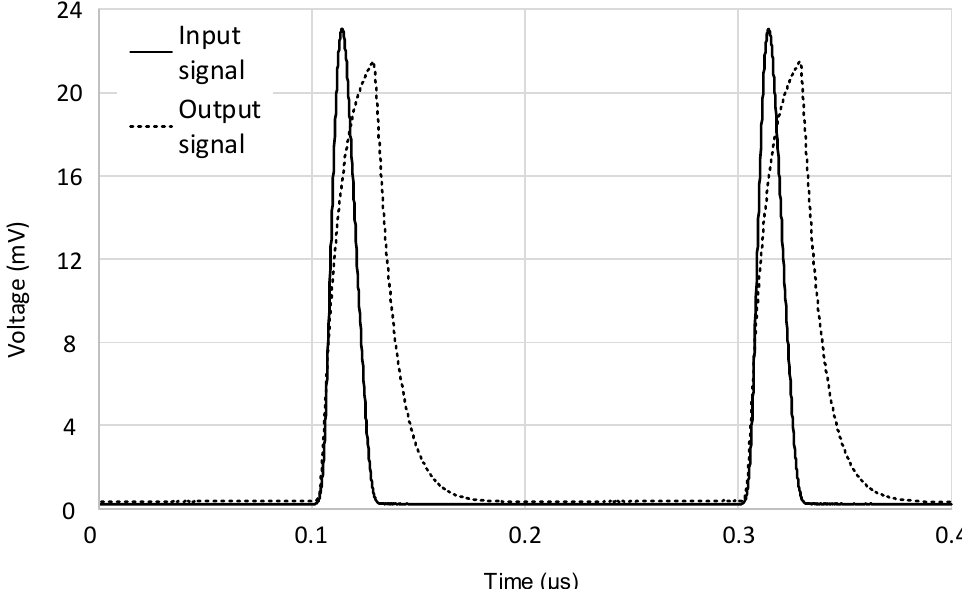
Figure 12. Multi-pulse input signal (continuous line) and measured output response (dotted line) of the discrete interface.